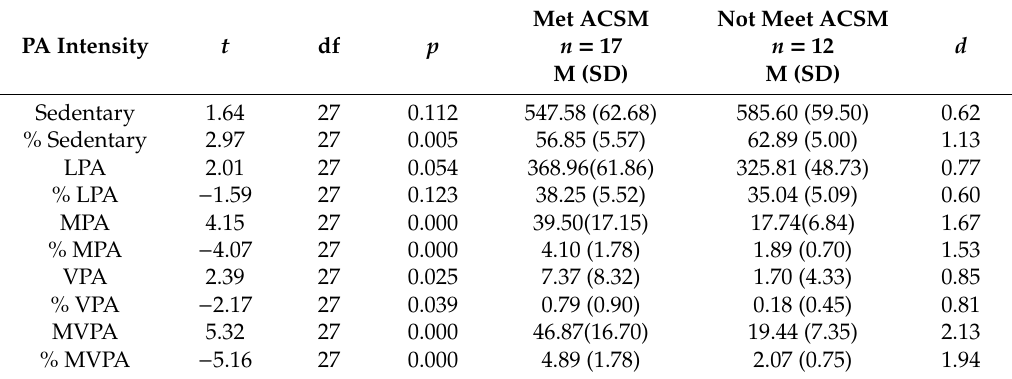
Table 3. Independent samples t -test values and e ff ect sizes ( d ) for on-duty PA intensities for firefighters meeting and not meeting American College of Sports Medicine (ACSM)